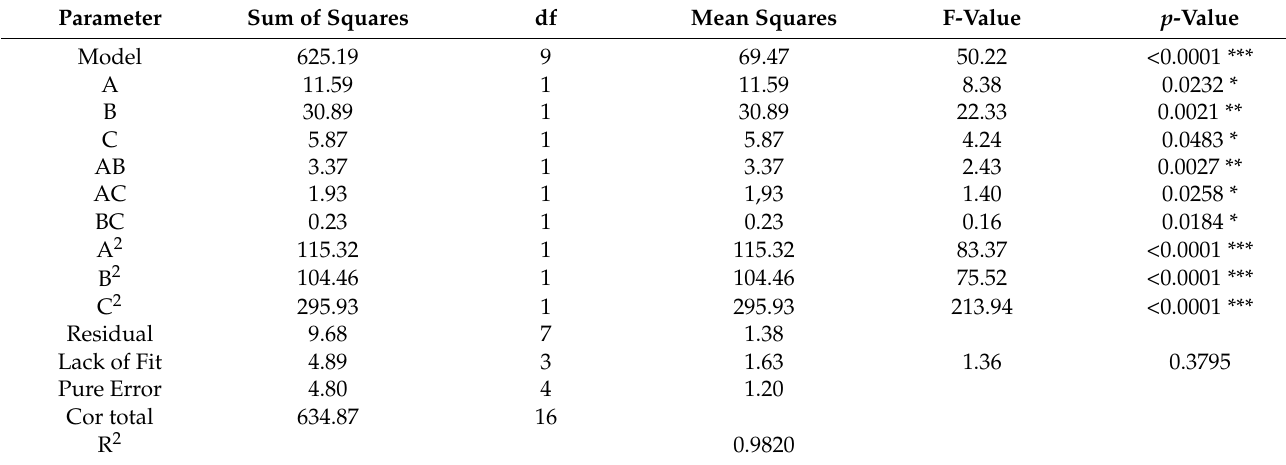
Table 2. Response surface quadratic model ANOVA and regression coefficient